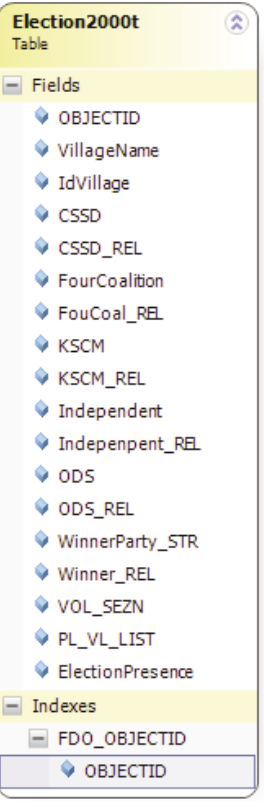
Fig. 1. Structure of the table with results of election for the year 2000